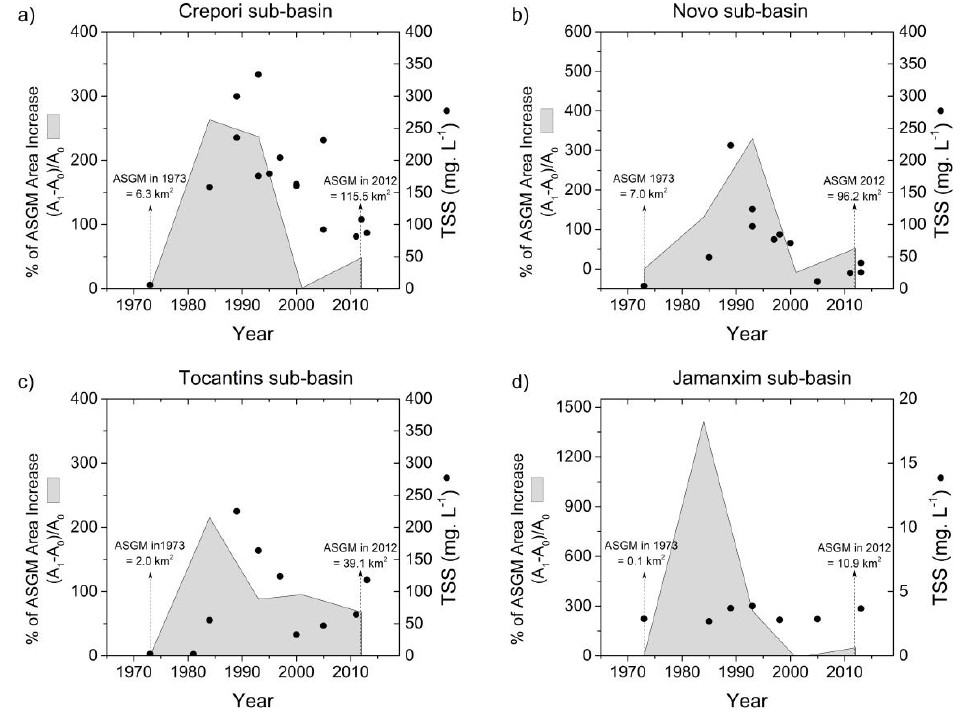
Figure 10. Percentage of ASGM area increase from 1973 to 2012 plotted along with historical TSS derived from [12] for the four sub-basins studied ( a – d ). Note different TSS scale for the Jamanxim River